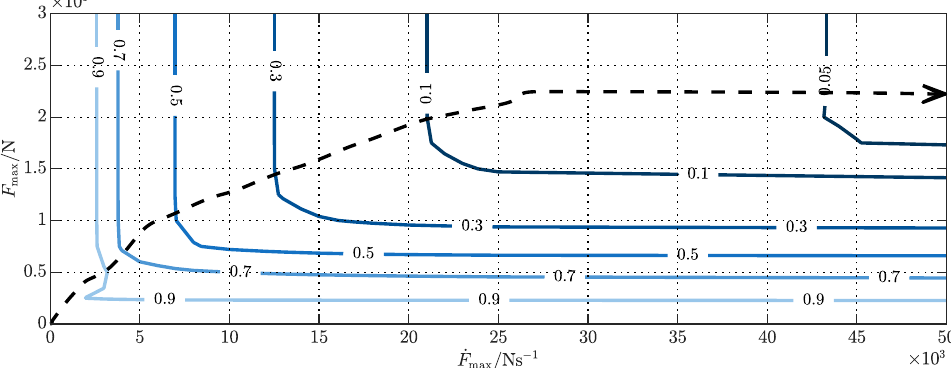
Figure 9. RMS body acceleration contour plot for the 36kmh − 1 single-obstacle